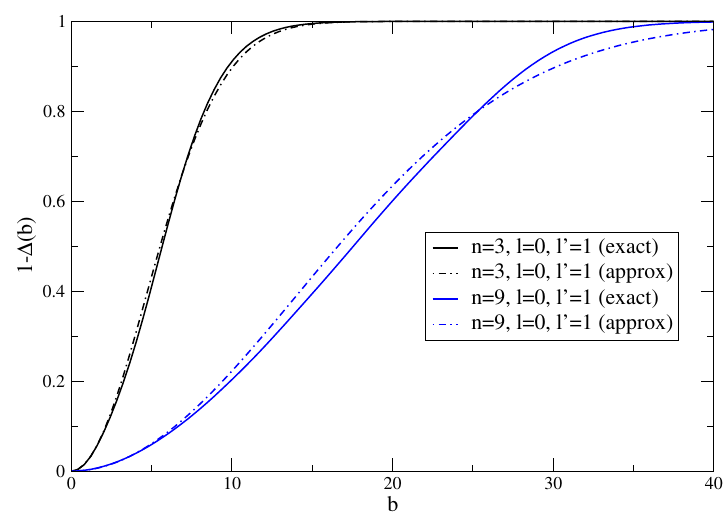
Figure 1. Comparison between the exact computation of [ 1 − ∆ ( b )] (Equations (27)–(29)) and the approximate expression (33) for (cid:96) = 0, (cid:96) (cid:48) = 1 and two values of principal quantum number n : 3 and 9.